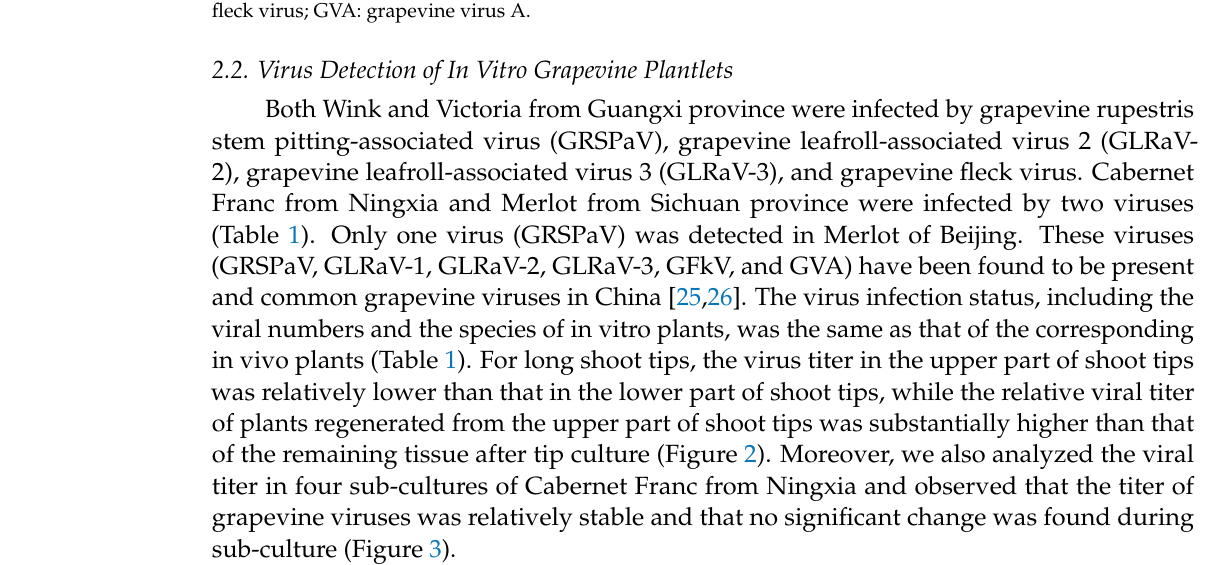
GRSPaV: grapevine rupestris stem pitting-associated virus; GLRaV-1: grapevine leafroll-associated virus 1; GLRaV-2: grapevine leafroll-associated virus 2; GLRaV-3: grapevine leafroll-associated virus 3; GFkV: grapevine fleck virus; GVA: grapevine virus A.